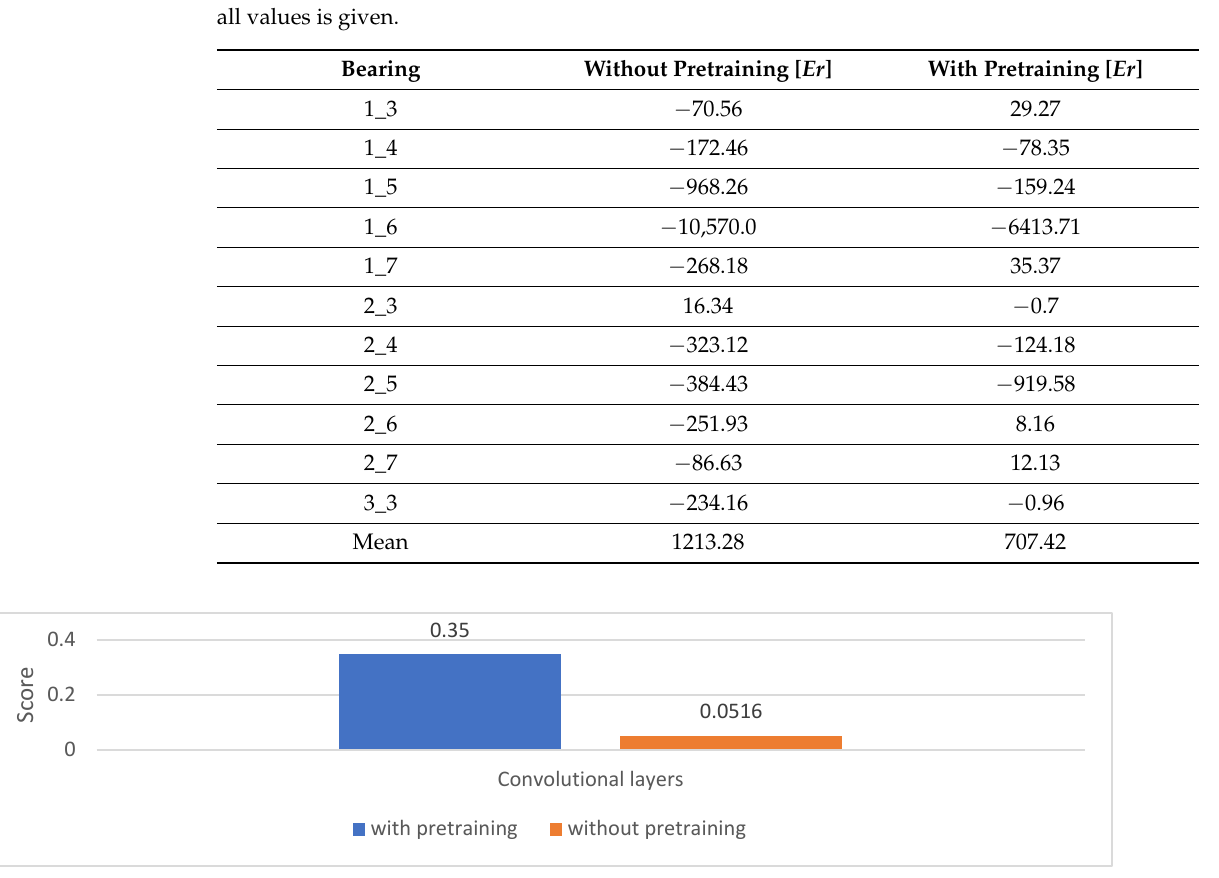
Figure 10. The scores for the RUL estimation with and without pretraining of the convolutional layers. The score achieved with pretrained layers is much higher than that without pretraining.